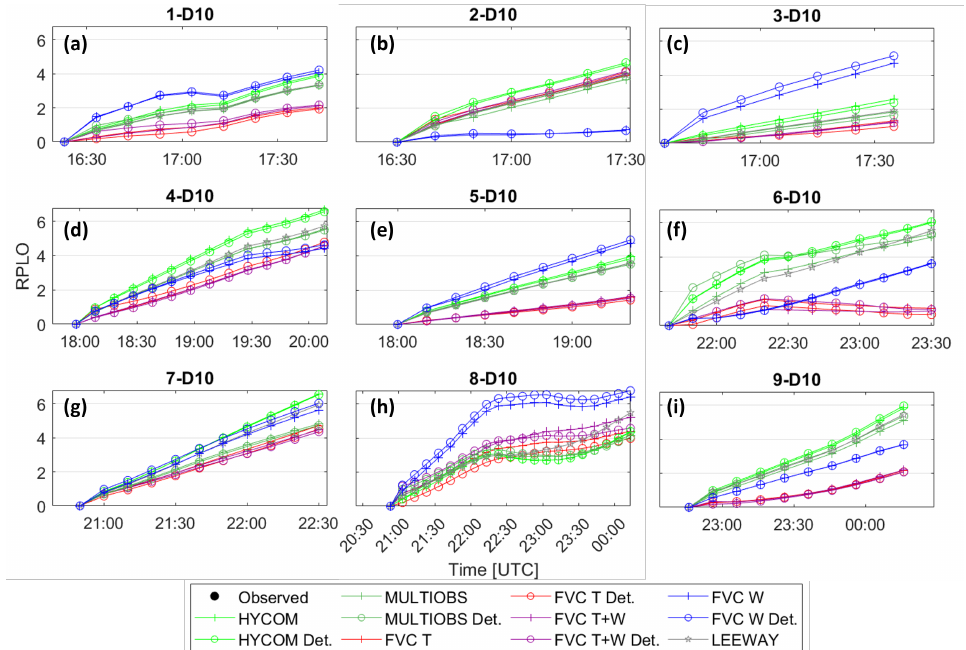
Figure 12. Time evolution of NCLS mod values during 10 September 2011. ( a – i ) Drifter deployments 1–9, respectively, as indicated in Figure 9a. Panel titles indicate drifter deployment number (X- D10, where X is drifter number). FVC = FVCOM; T = Tide; W = Wind; Det. = deterministic (drag force)